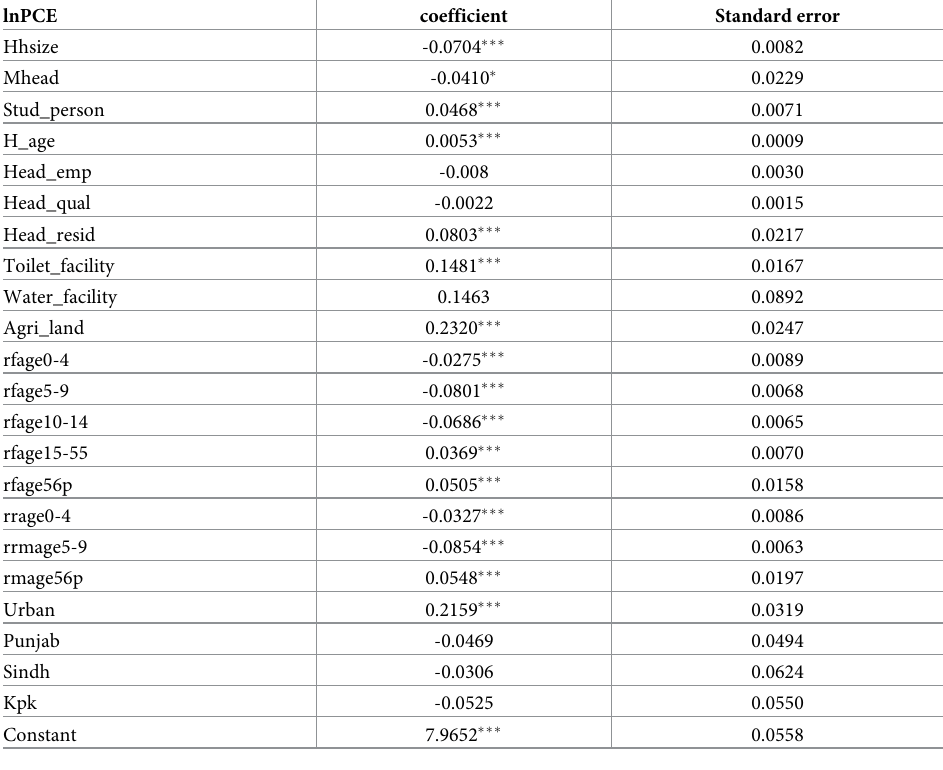
Table 7. OLS Regression estimates with partially simulated error 2010–11.